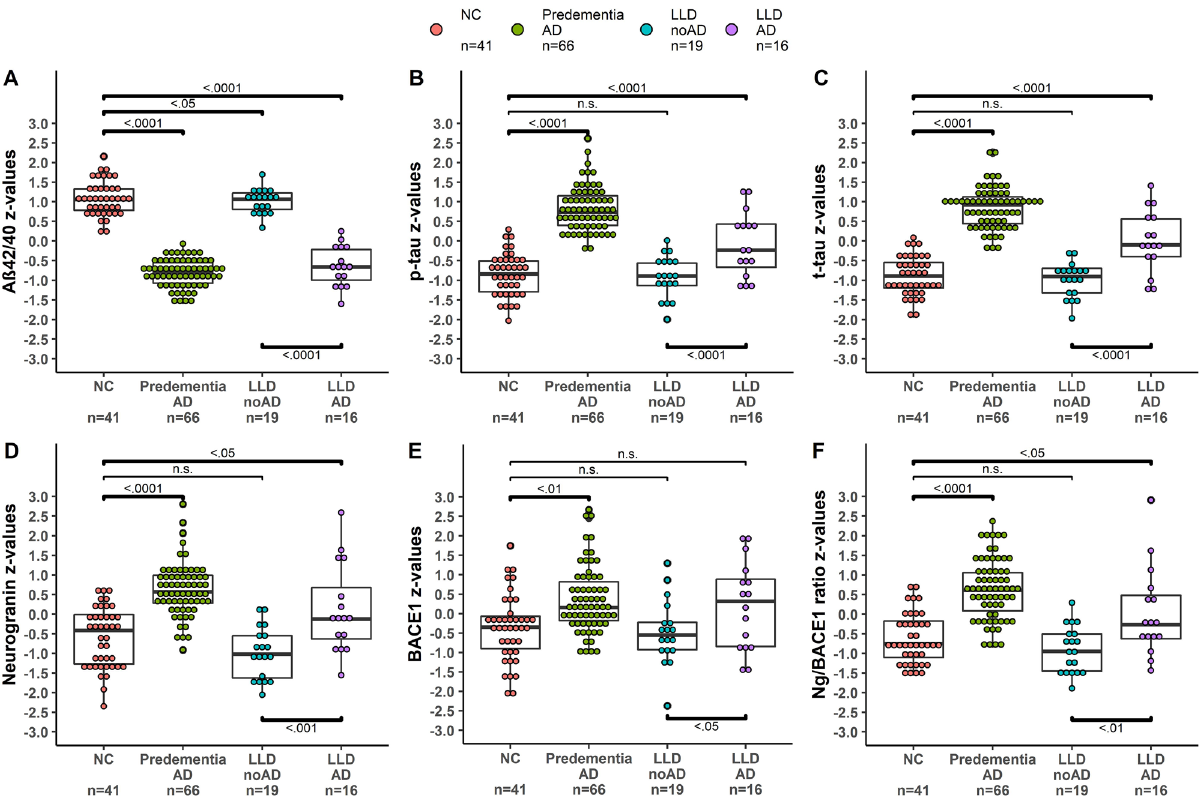
Figure 2. Scatter dot plots for CSF concentrations of ( A ) Aβ42/40 ratio, ( B ) P-tau and ( C ) T-tau (CSF markers for AD pathology) and of ( D ) neurogranin (Ng), ( E ) BACE1 and ( F ) Ng/BACE1 ratio (CSF Synapse biomarkers). The lines in the plots represent the mean values, the bars the standard deviation. Statistical significance at p < 0.05; n.s. = non significant. NC = normal controls; predementia AD = predementia Alzheimer’s disease; LLD NoAD = late life depression without AD pathology; LLD AD = late life depression with AD pathology (pathologic Aβ42/40 ratio, varying combinations of pathologic P-tau and